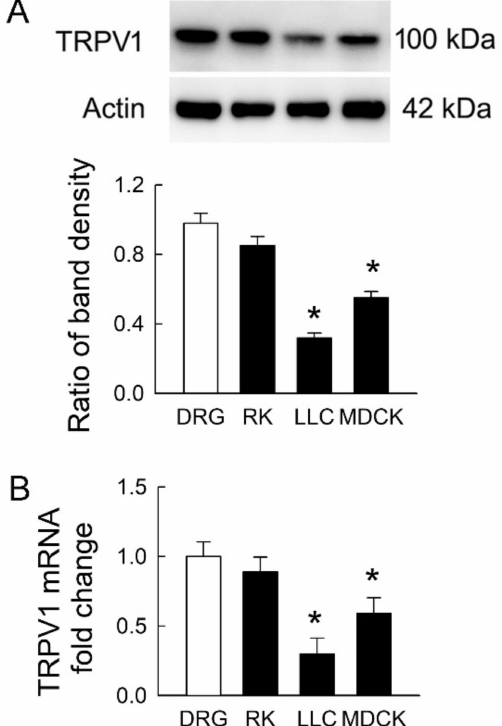
Figure 2. Transient receptor potential vanilloid type-1 (TRPV1) expression in tubular cell lines. ( A ) Representative immunoblots show TRPV1 expression in rat dorsal root ganglia (DRG) tissues, rat kidney (RK), LLC-PK 1 cells (LLC), and MDCK cells using 20 µ g of the total protein in each lane. The lower bar graph shows densitometrically quantified results by the ratio of TRPV1 to β -actin; ( B ) The expression of TRPV1 mRNA in rat tissues and tubular cells was examined by real-time quantitative RT-PCR. n = 4 of experiments performed in each group. * p < 0.05 versus